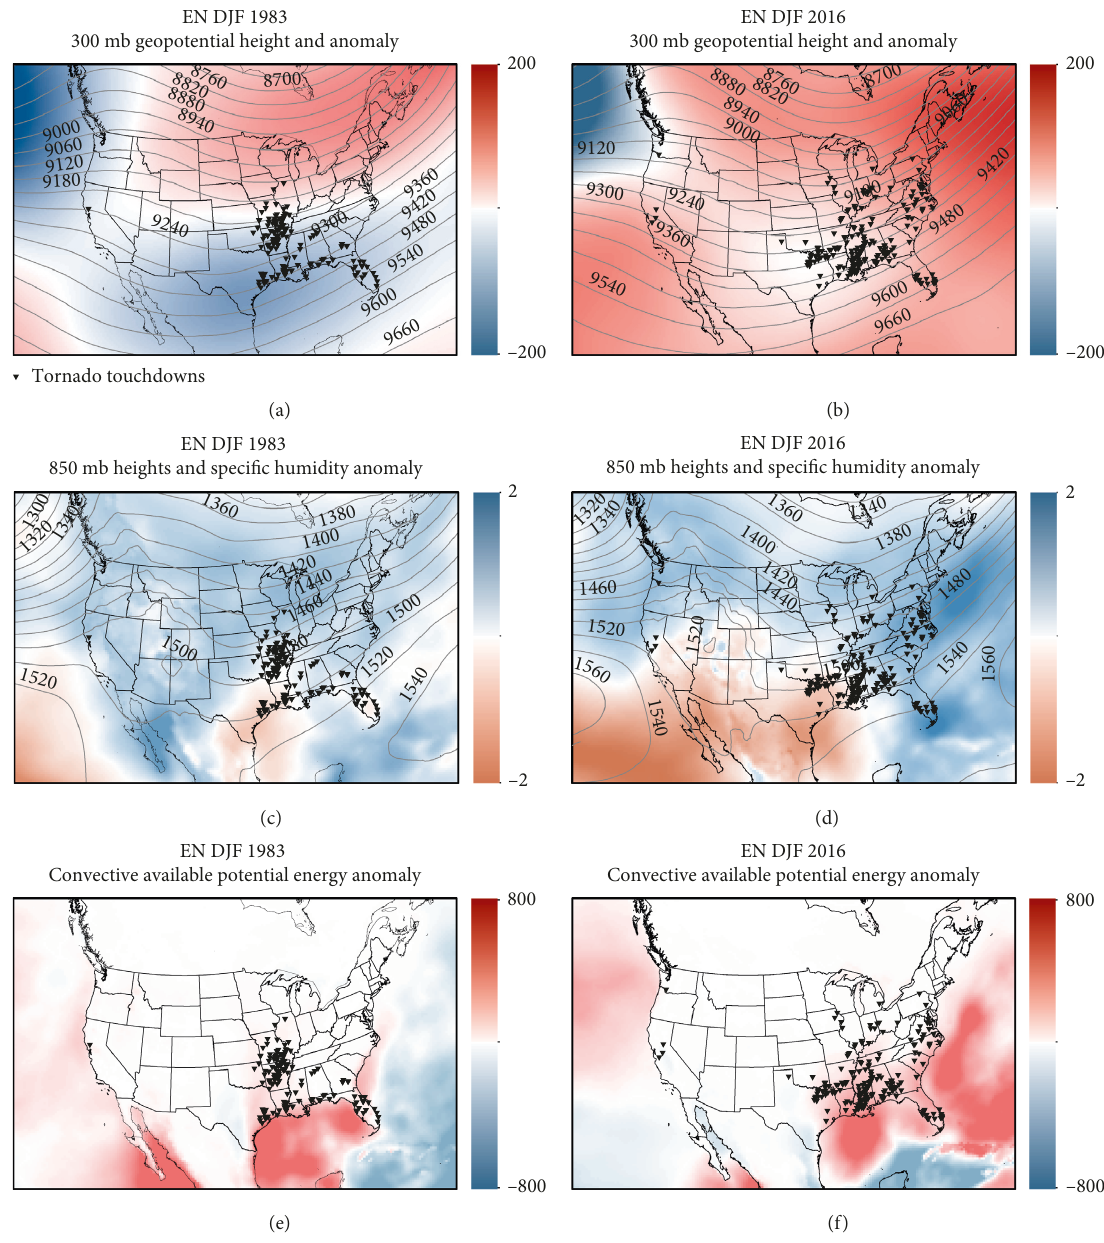
Figure 5: (a, b) 300mb geopotential heights (contours (m)) and anomalies (color (m)), (c, d) 850 mb geopotential heights (contours (m)) and specific humidity anomalies (color (g